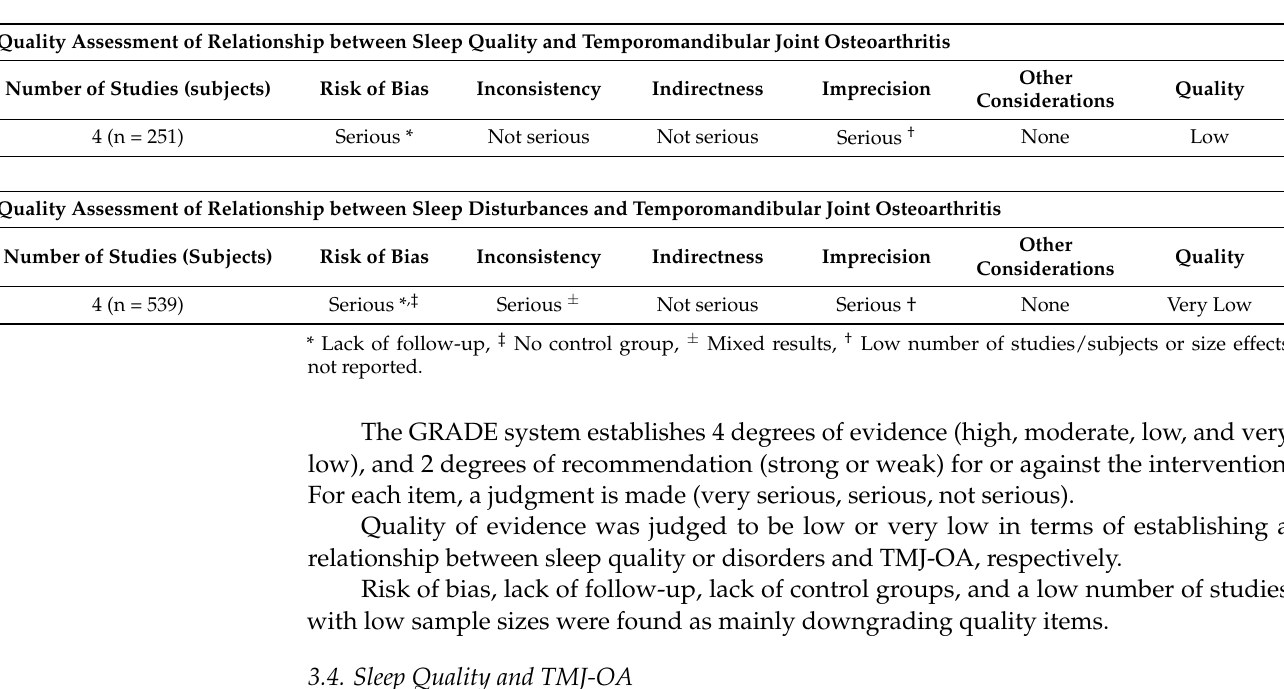
Table 4. Summary of findings for clinical trials, including GRADE quality of evidence